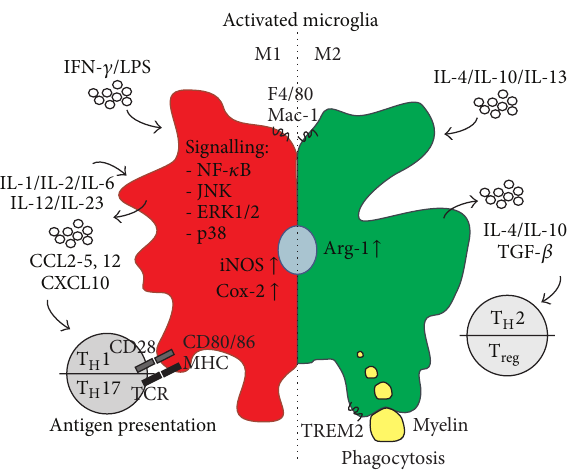
Figure 1: Polarization and function of activated microglia in CNS autoimmune inflammation. Microglia are activated by diverse stimuli, which define the polarization status of the cell. While IFN- 𝛾 /LPS promote the proinflammatory M1 status, IL-4/IL-10 or IL-13 induce the anti-inflammatory M2 status. M1 microglia take part in the attraction and differentiation of pathogenic T T-cells, whereas M2 microglia promote phagocytosis of myelin debris, which is important for